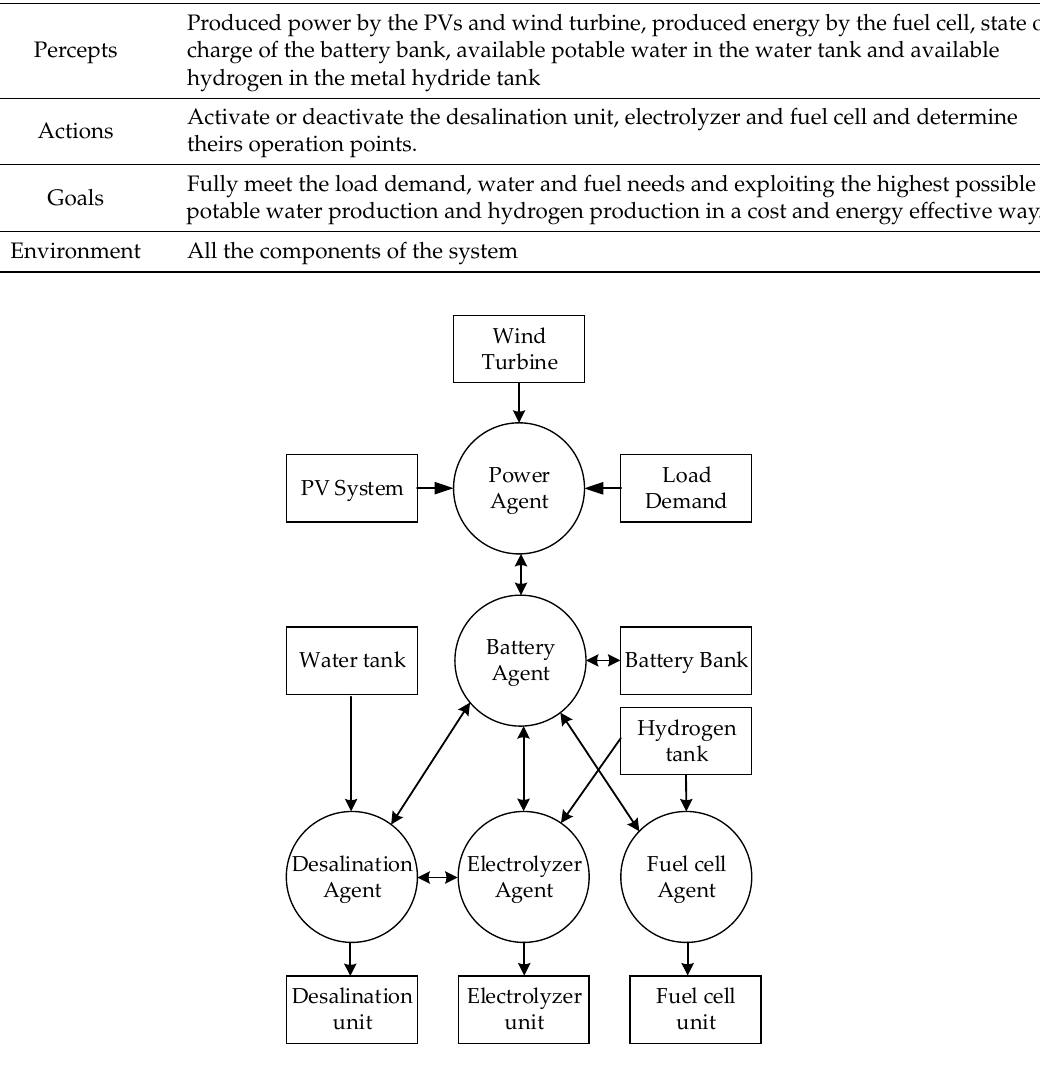
Figure 2. MAS topology.